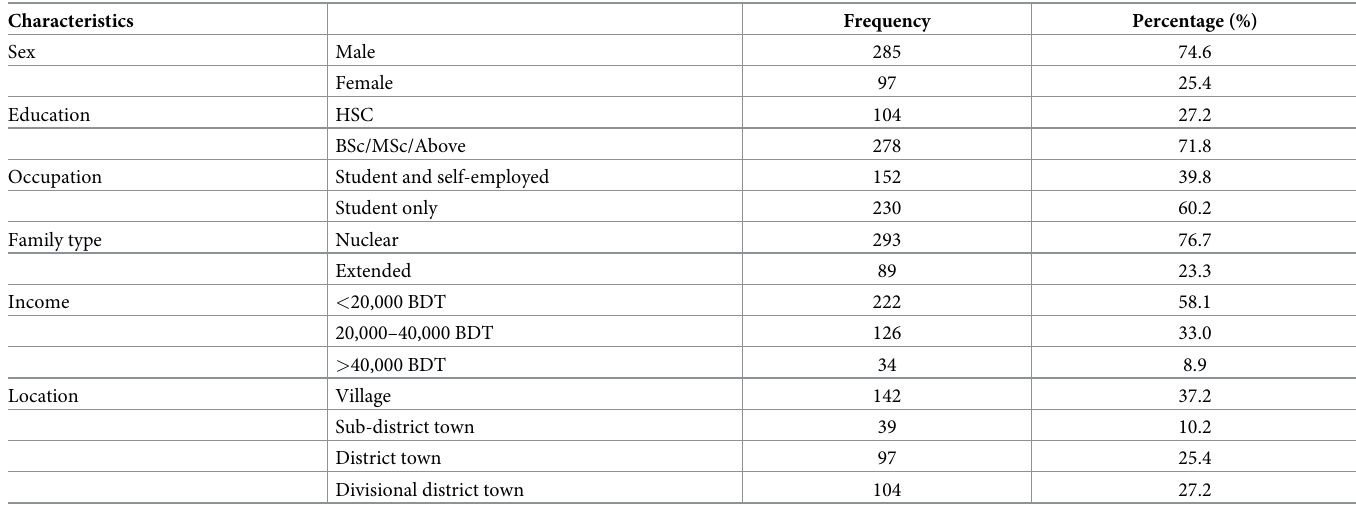
Table 1. Socio-demographic characteristics of the respondents.